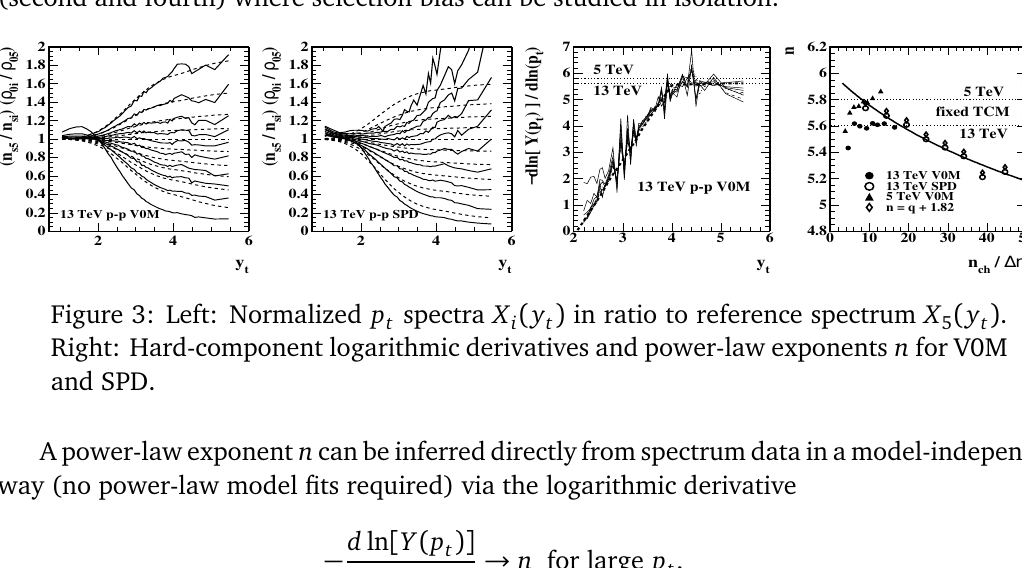
Figure 3: Left: Normalized p Right: Hard-component logarithmic derivatives and power-law exponents n for V0M and